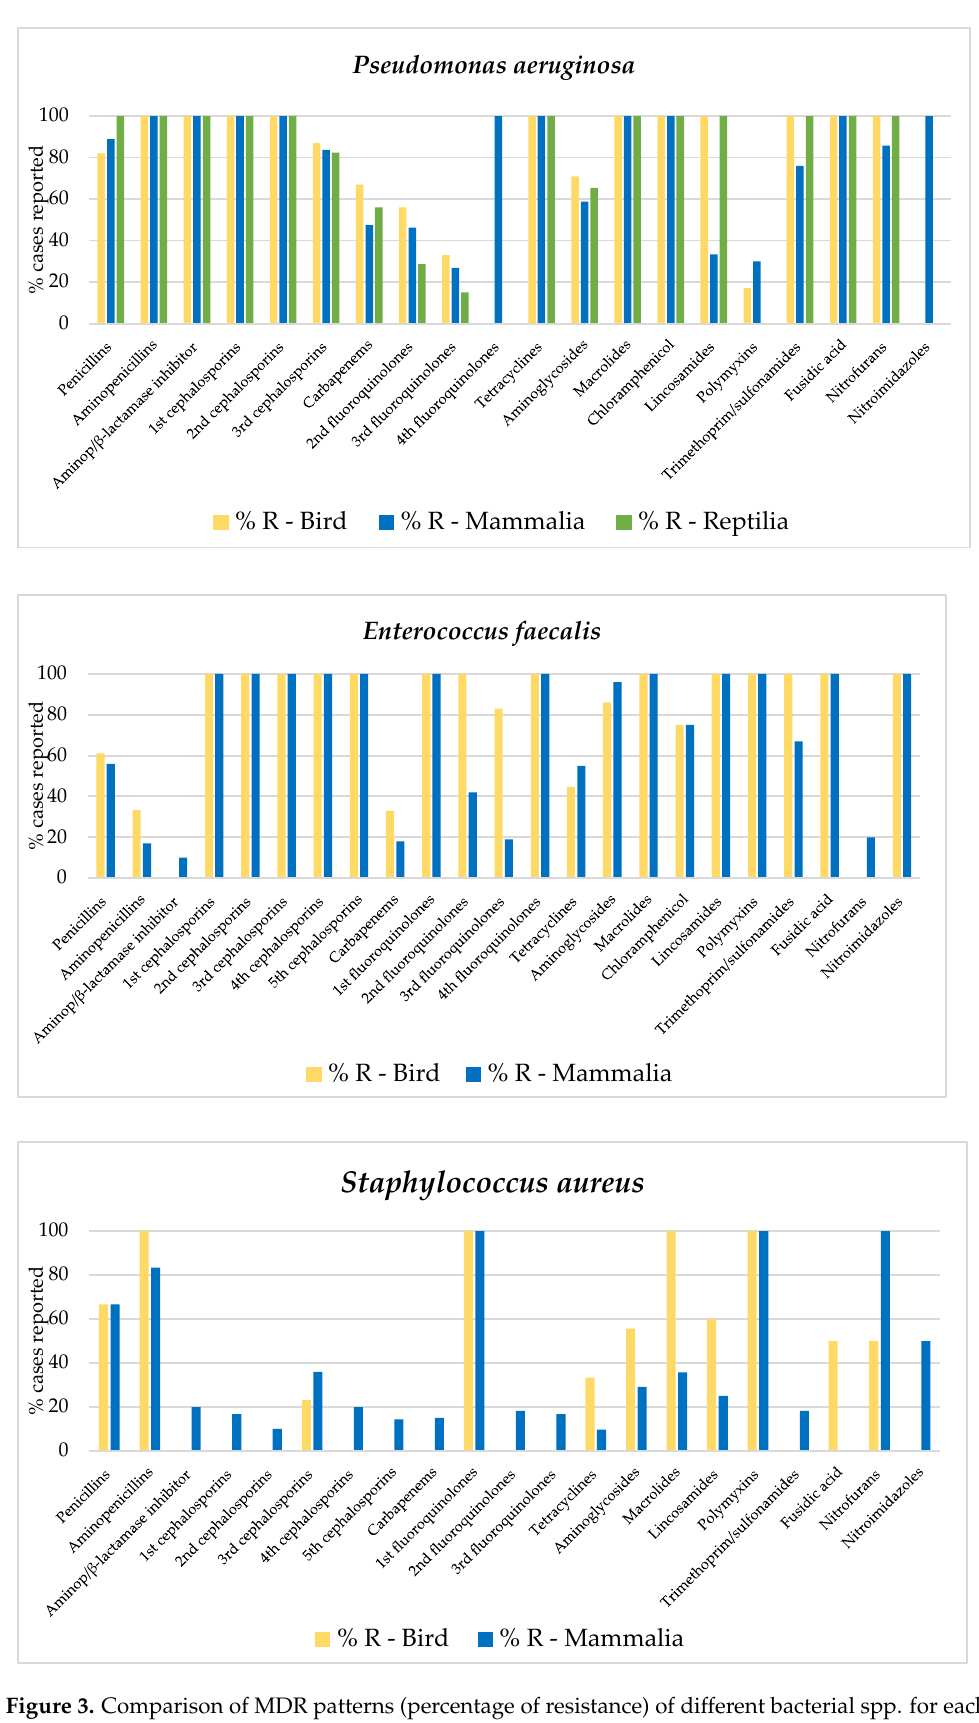
Figure 3. Comparison of MDR patterns (percentage of resistance) of different bacterial spp. for each animal